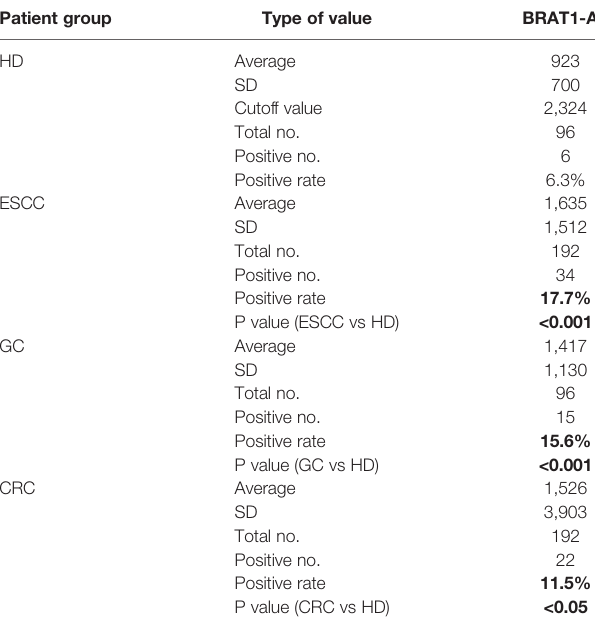
TABLE 5 | Univariate and multivariate analysis of risk factors for overall survival in the patients with ESCC. Univariate